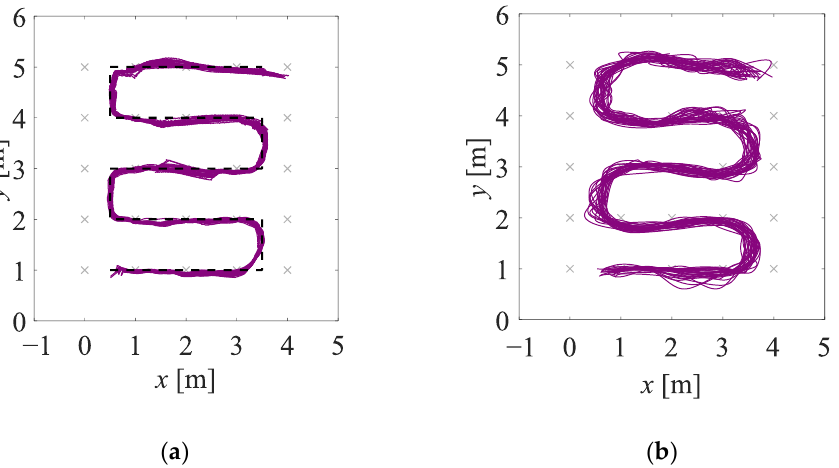
Figure 9. Estimates of the trajectories obtained in EXP#1, by means of the NARX method ( a ), and the WINFNS method described in [37] ( b ); for the NARX method, the value of the A ECDF indicator is 0.85, while for the WINFNS method, it is 0.83.